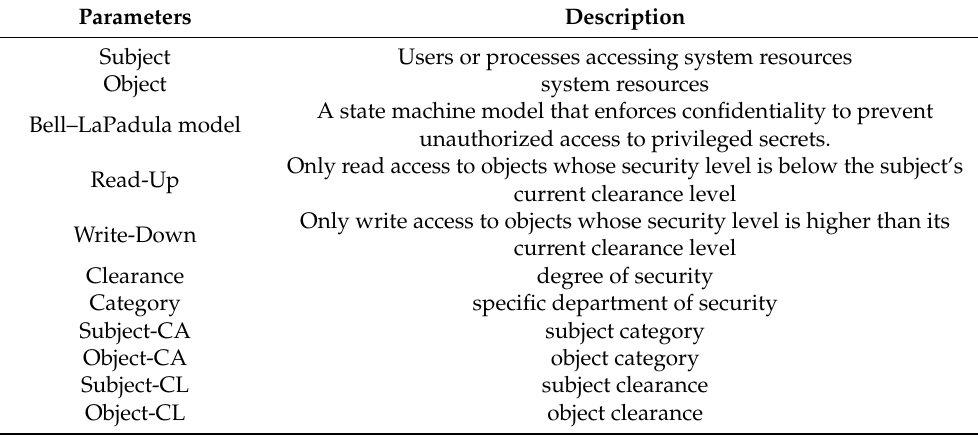
Table 2. Algorithm